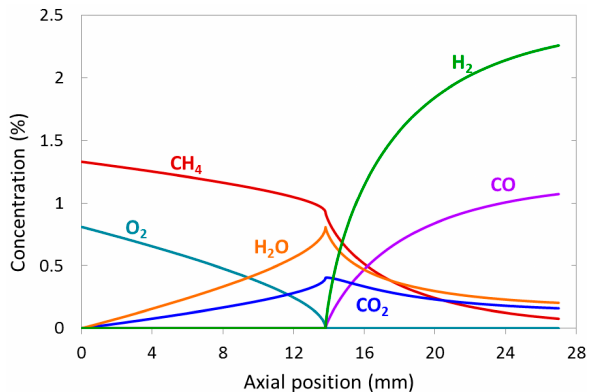
Figure 4. Computed concentration of the gas-phase species: O 2 , CH 4 , H 2 , H 2 O, CO and CO 2 along the catalytic bed after the ignition for partial oxidation of methane over nickel at 973 K, CH 4 /O 2 = 1.6 and 1 bar.